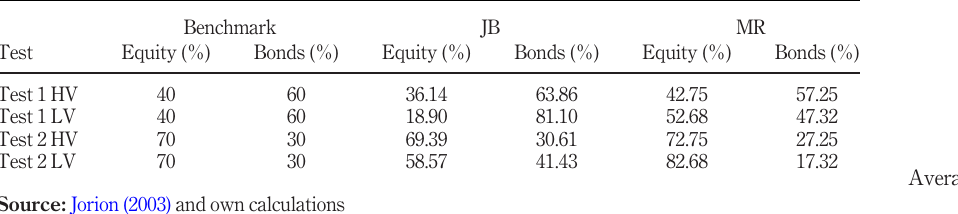
Table 5. Average